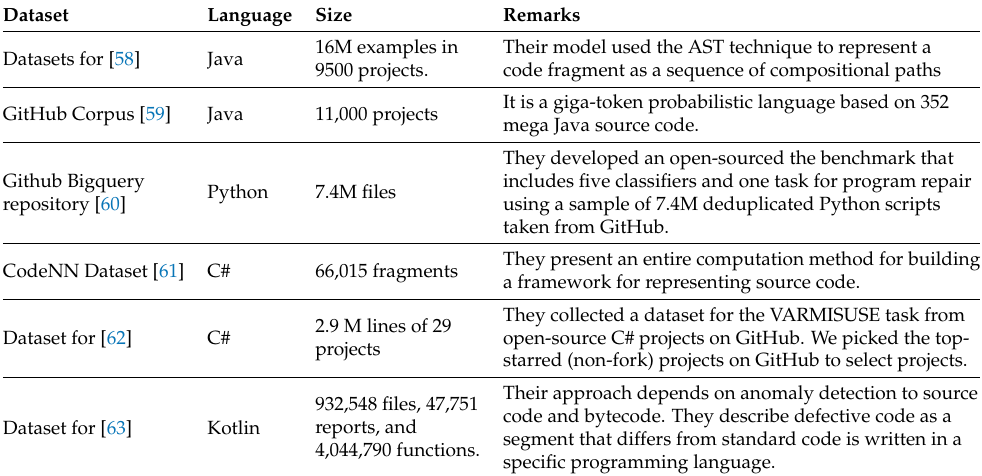
Table 3. Unlabeled source code